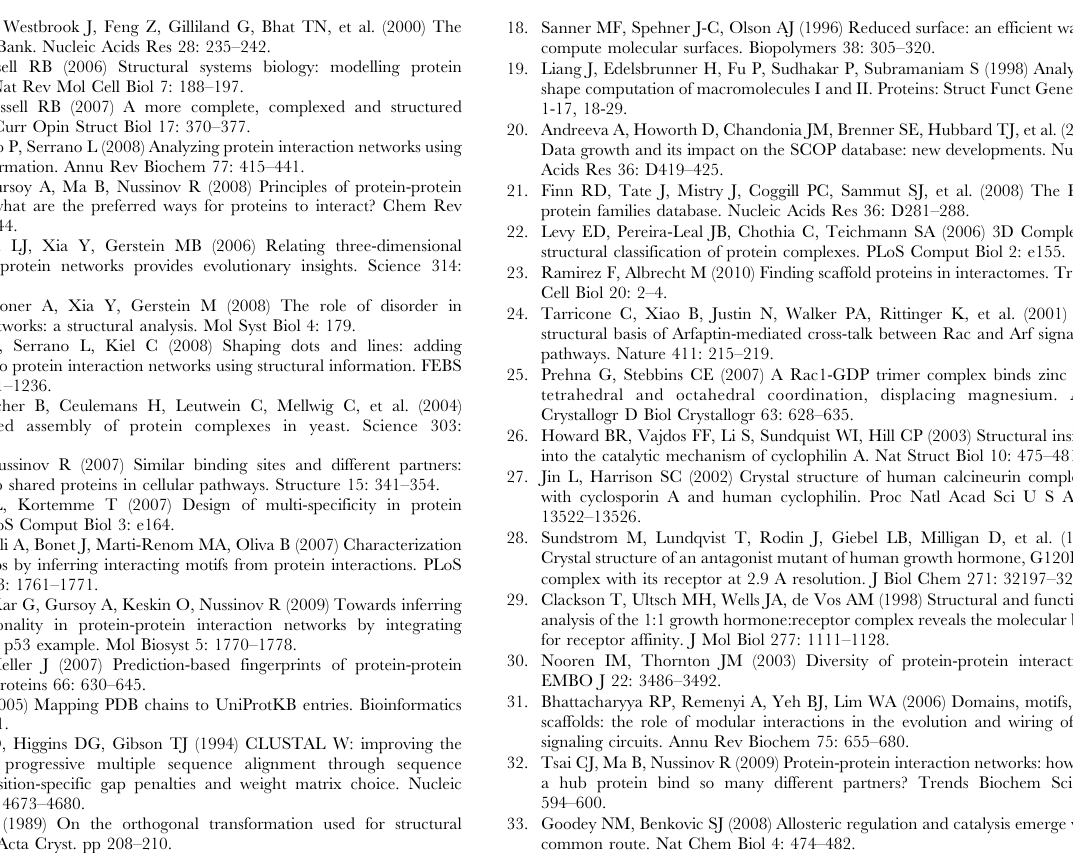
Table S4 GO annotations of Pfam domains. (PDF) Table S5 List of colliding protein interaction pairs after filtering with 3D